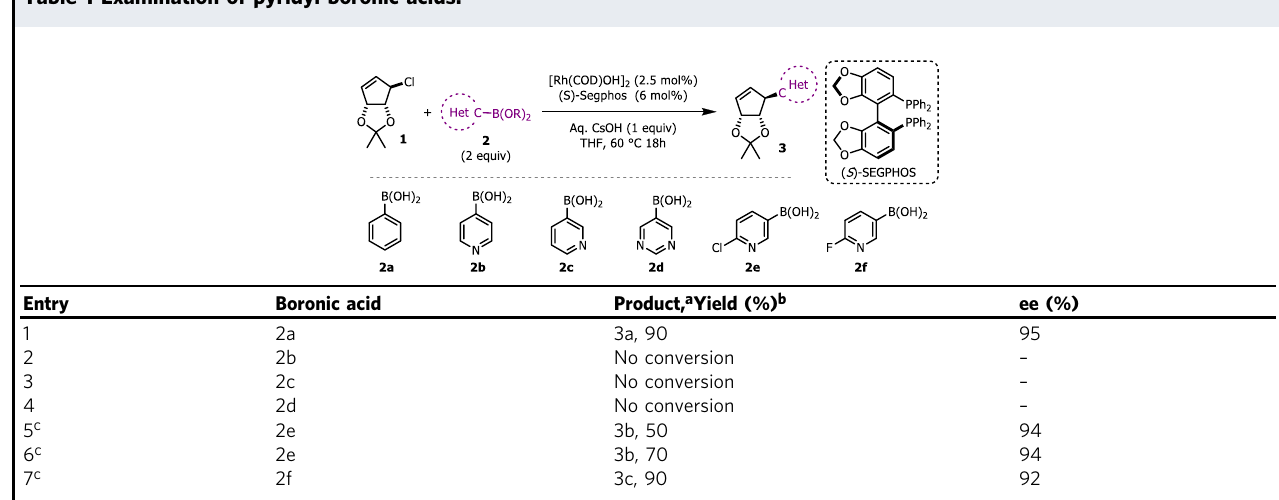
Table 1 Examination of pyridyl boronic